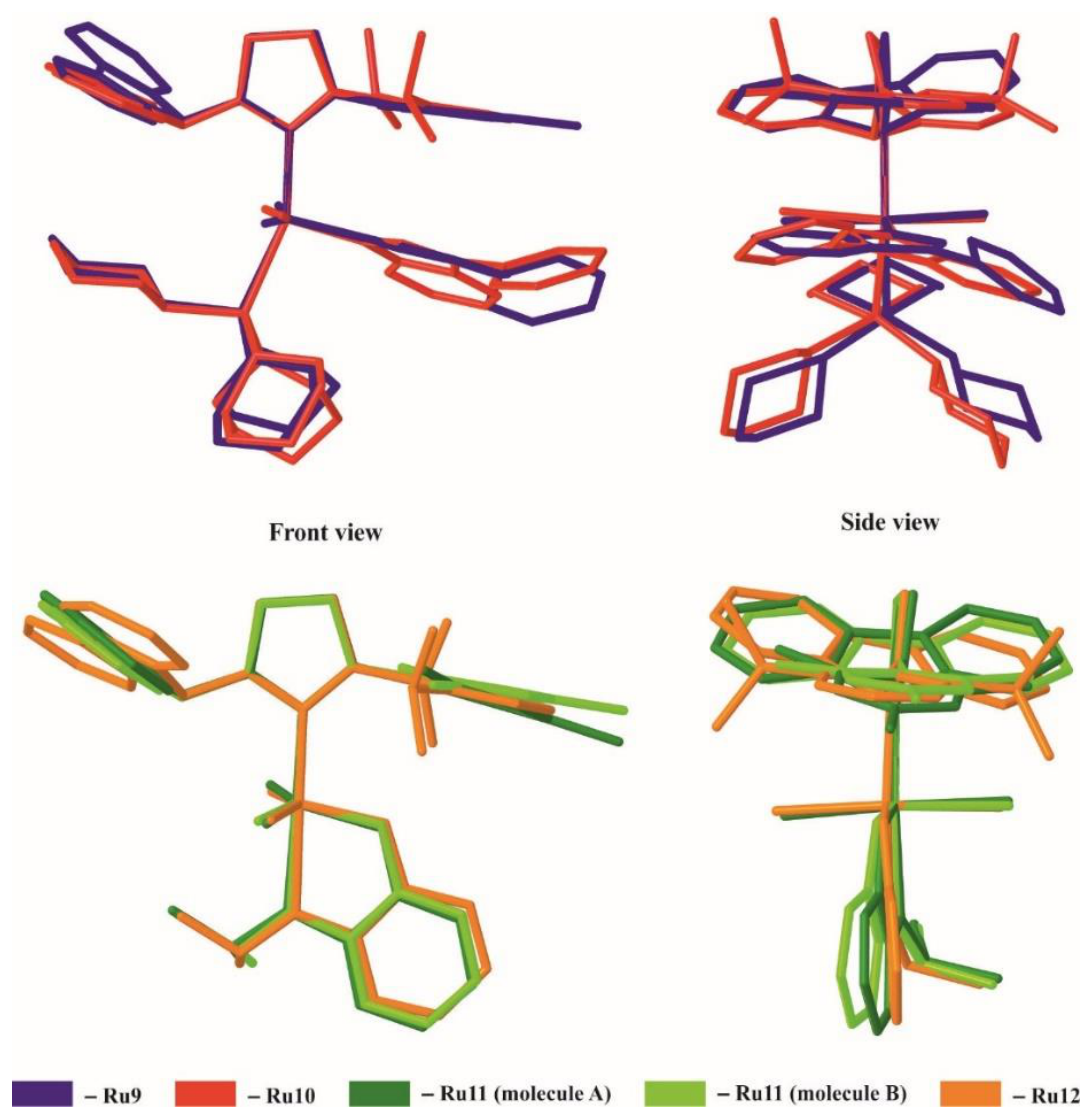
Figure 4. Superimposed molecules of Ru9 – Ru12 . The hydrogen atoms were omitted for clarity. The aromatic rings of the mesityl and the diisopropylphenyl substituents in both phosphonium ◦ above moieties are inclined to each other by the angle of 8.5(3) and the intramolecular π – π